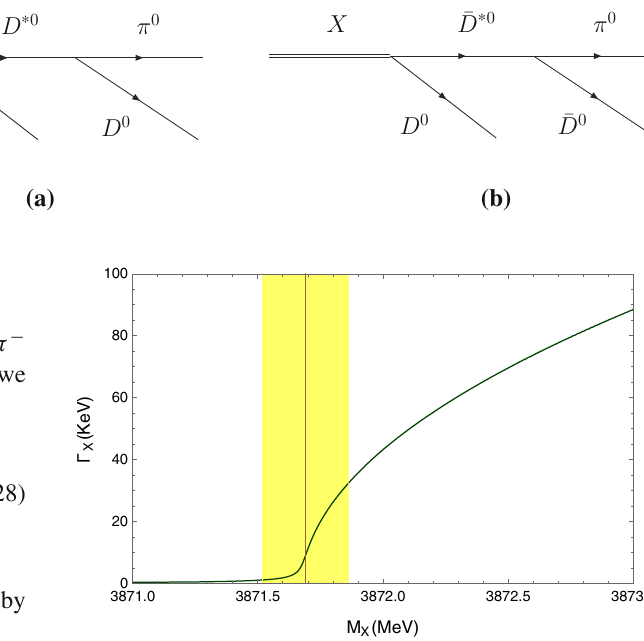
Fig. 6 (cid:9) X for X → π 0 D 0 ¯ D 0 as a function of M X calculated with g X = 2 GeV. The vertical line and yellow error band represent the X(3872) mass and error according to Eq.